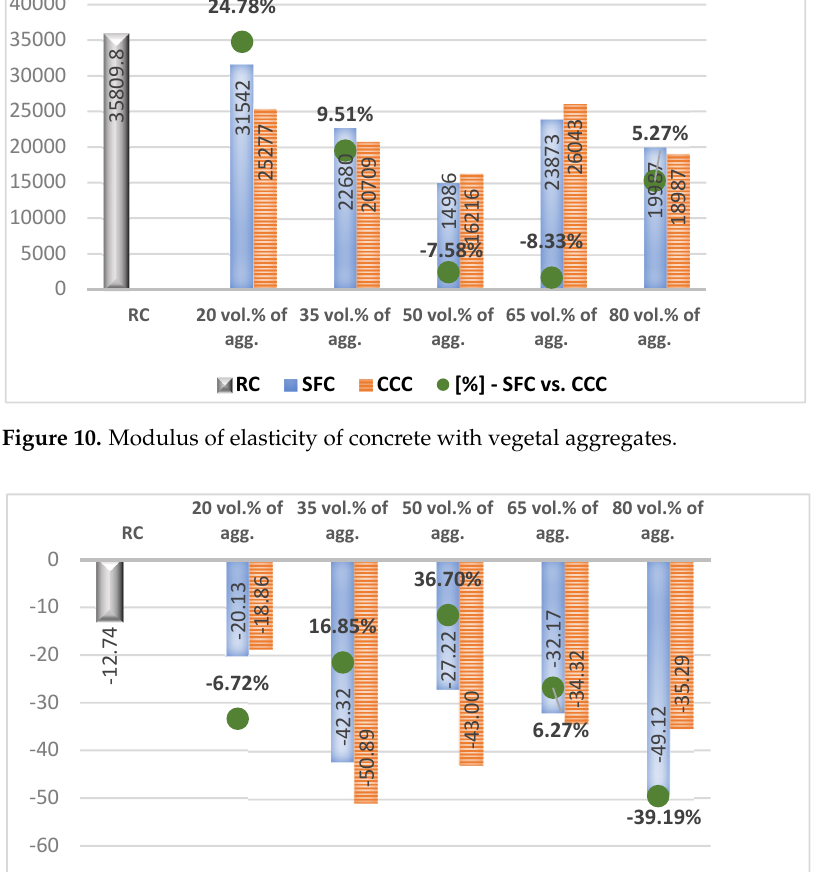
Figure 10. Modulus of elasticity of concrete with vegetal aggregates.